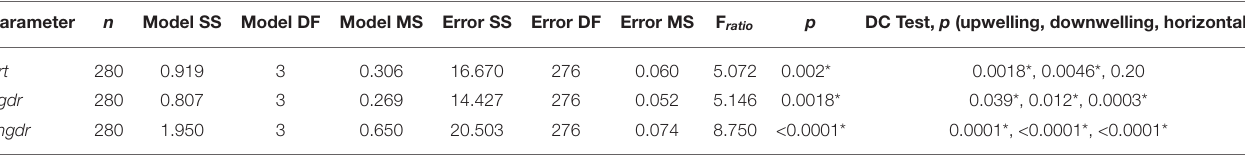
*Indicates statistical significance (p ≤ 0.05 ) of shear flow values relative to the control (no-flow)